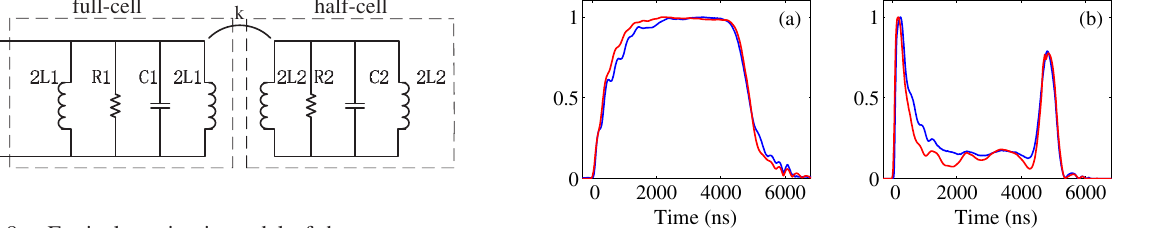
FIG. 8. Equivalent circuit model of the gun.